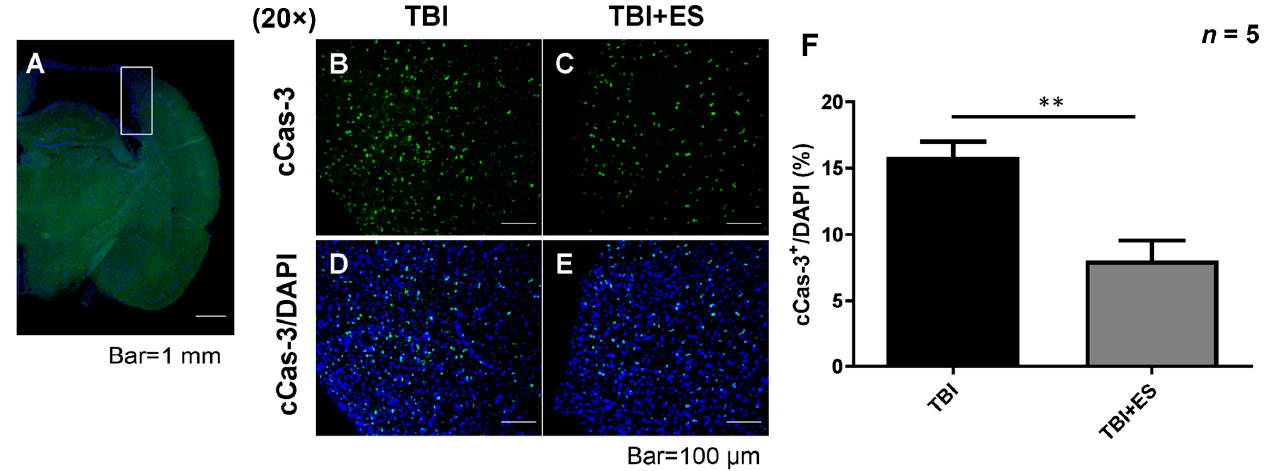
Figure 4. CES reduced cleaved caspase 3 (cCas-3) immunoreactive cells in the perilesional cortex. ( A ) Representative picture illustrating the sample region for the perilesional cortex. The cortical specimen was obtained within 1 mm from the wall of the lesion cavity. ( B , C ) Representative pictures of immunofluorescent for cCas-3 (green). ( D , E ) Representative pictures of merged immunofluorescent of DAPI (blue) with cCas-3. ( F ) Quantitative analysis showed a significantly decreased number of cCas-3 immunoreactive cells. Values are expressed as the mean ± SEM. ** p < 0.001.